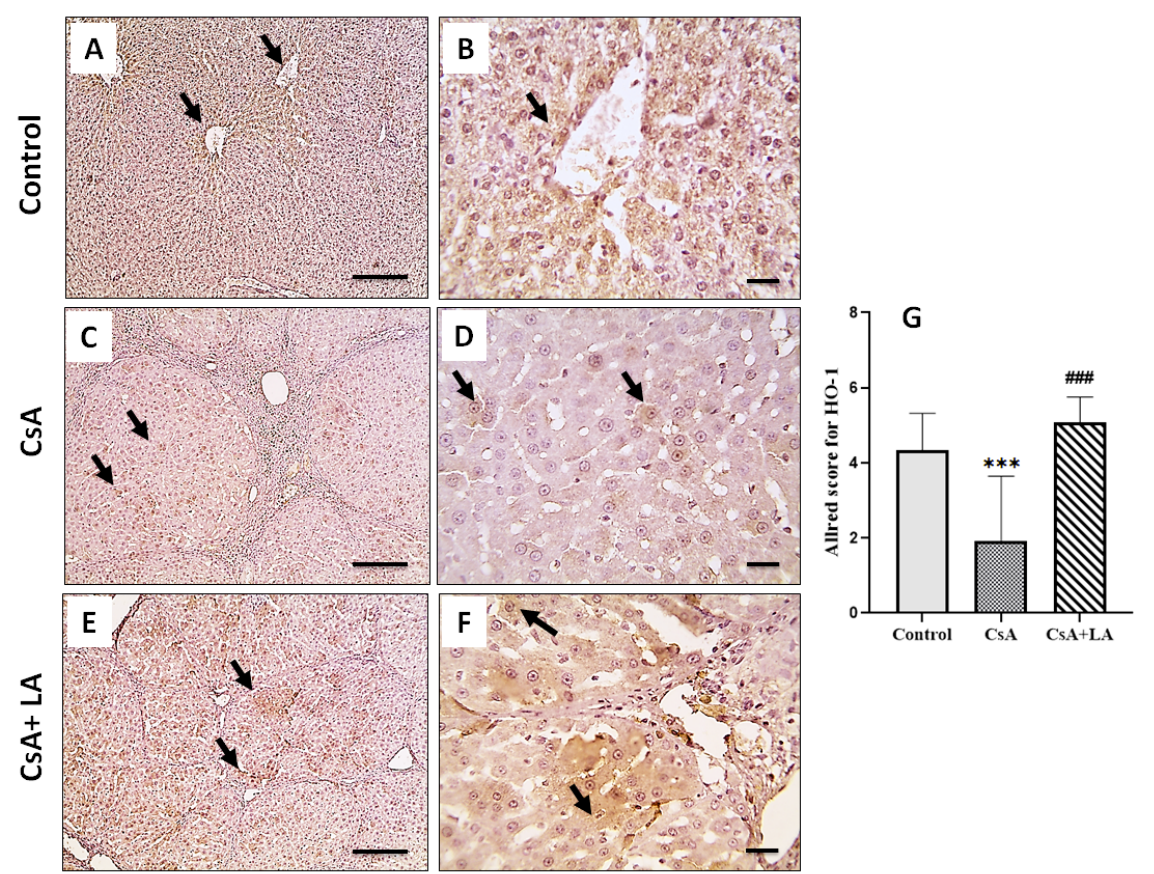
Figure 3. Microscopic pictures of immunostained hepatic sections against HO-1. The control normal group ( A , B ) showing many positively stained perisinusoidal liver cells (arrows). Hepatic sections ( C , D ) from CsA-treated group show few positively stained parenchymal liver cells (arrows). Hepatic sections ( E , F ) from the (CsA + LA)-treated group show significantly increased numbers of positively stained liver cells, perisinusoidal, and in the liver parenchyma (arrows). IHC was counterstained with Mayer’s hematoxylin, ( A , C , E ; Scale bar = 100 μ m), and ( B , D , F ; Scale bar = 50 μ m). ( G ) represents an Allred score for HO-1 cytoplasmic expression. Data are expressed as the mean ± SE ( n = 8). *** p < 0.001 versus the control group, ### p < 0.001 versus the CsA group. Allred index (0–1 = negative, 2–3 = mild, 4–6 = moderate, and 7–8 = strongly positive). Table 2. Effect of α -LA administration on serum oxidative stress in CsA-treated animals. Parameter